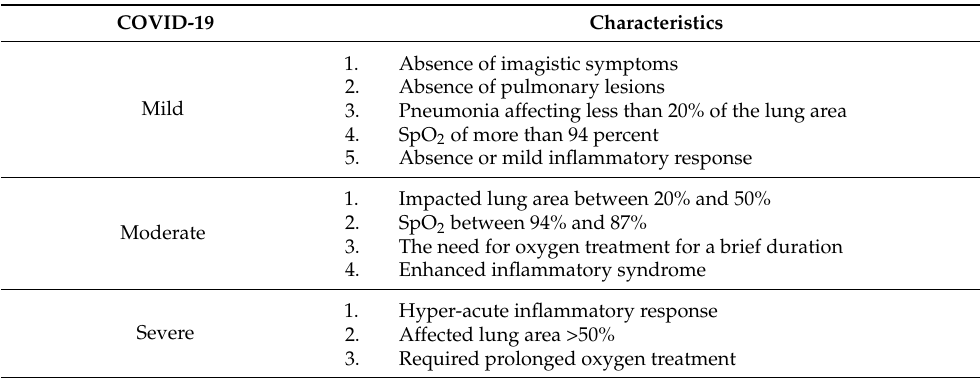
Table 1. COVID-19-severity